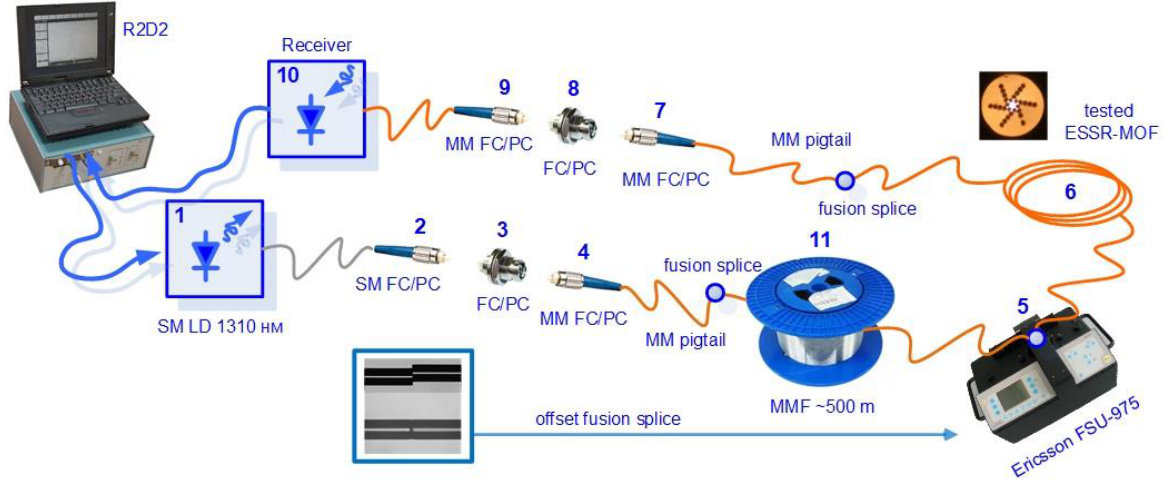
Figure 18. Modified setup for DMD map measurements: spool with MMF Cat. OM2 “11” (Tx) and tested ESSR-MOF “6” (Rx) with precision offset between optical fiber centers.